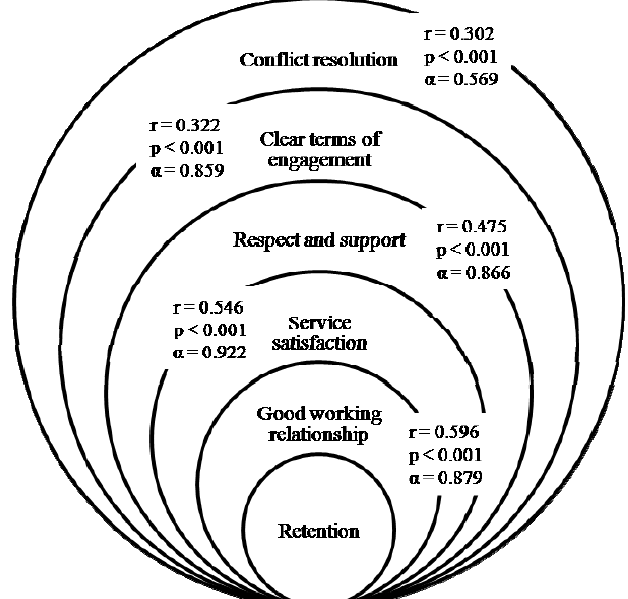
Figure 1: Agency retention consideration